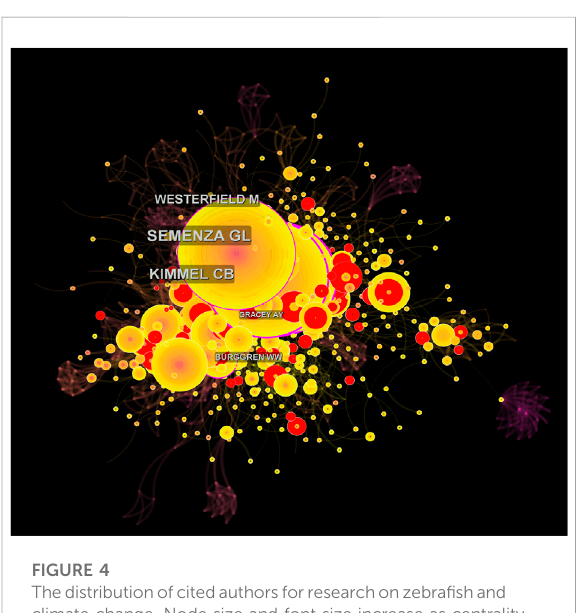
FIGURE 4 Thedistributionofcitedauthorsforresearchonzebra fi shand climate change. Node size and font size increase as centrality score increases.